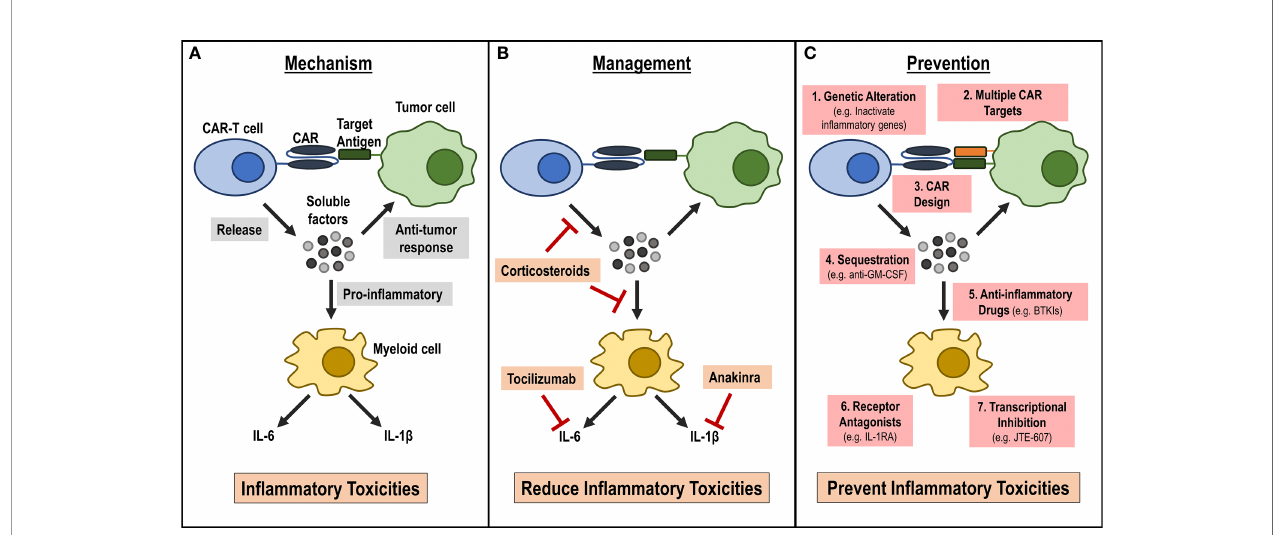
FIGURE 1 | Current understanding of mechanism for in fl ammatory toxicities during CAR-T cell therapy, current management strategies and future strategies for prevention. (A) Mechanism: Activated CAR-T cells release soluble factors upon CAR engagement with target antigen. These soluble factors can aid in the anti-tumor response, or they can activate bystander myeloid cells. Activated myeloid cells secrete in fl ammatory cytokines, such as IL-6 and IL-1 b , that lead to the in fl ammatory toxicities observed in patients infused with CAR-T cells. (B) Management: Current management strategies focus on reducing in fl ammatory cytokines or cytokine signaling pathways by either using anti-in fl ammatory drugs, such as corticosteroids that may reduce in fl ammatory cytokines release by CAR-T cells or myeloid cells or by targeting speci fi c cytokine receptors, such as IL-6R by tocilizumab and IL-1R by anakinra. (C) Prevention: New approaches that focus on preventing the onset of CRS. These strategies include: 1) modifying CAR-T cells during manufacturing such as genetic alterations to inactivate in fl ammatory genes, 2) designing CARs with novel domains that are less in fl ammatory, 3) targeting multiple antigens on tumors to reduce on-target off-tumor activation, 4) inhibiting pro-in fl ammatory CAR-T cell factors using antibodies (e.g. anti-GM-CSF), or inhibiting myeloid cell activation by 5) using small molecule inhibitors (e.g. BTKI), 6) expressing in fl ammatory cytokine receptor (e.g. IL-1R) on CAR-T cells or 7) using myeloid cell-speci fi c transcriptional Inhibitor (e.g.